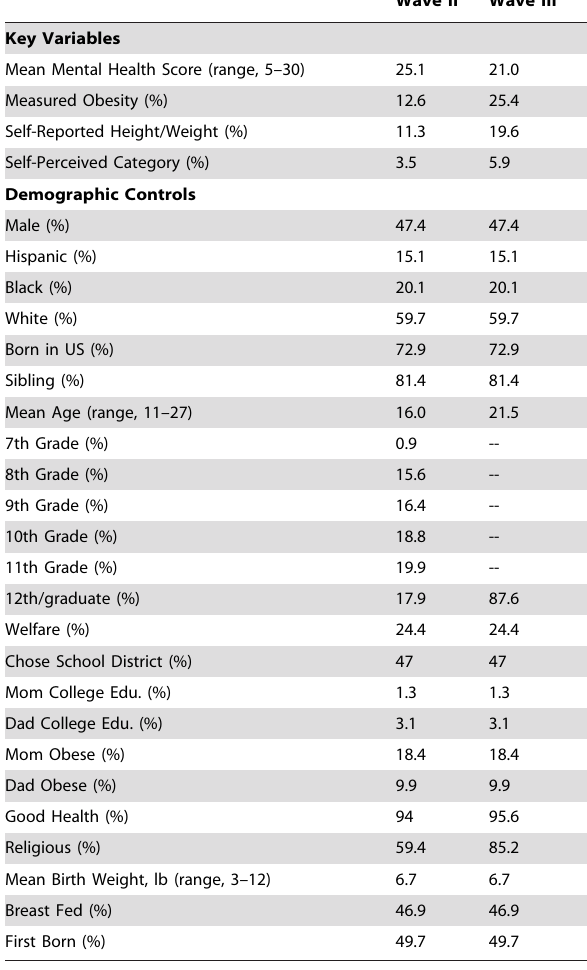
Table 1. Summary